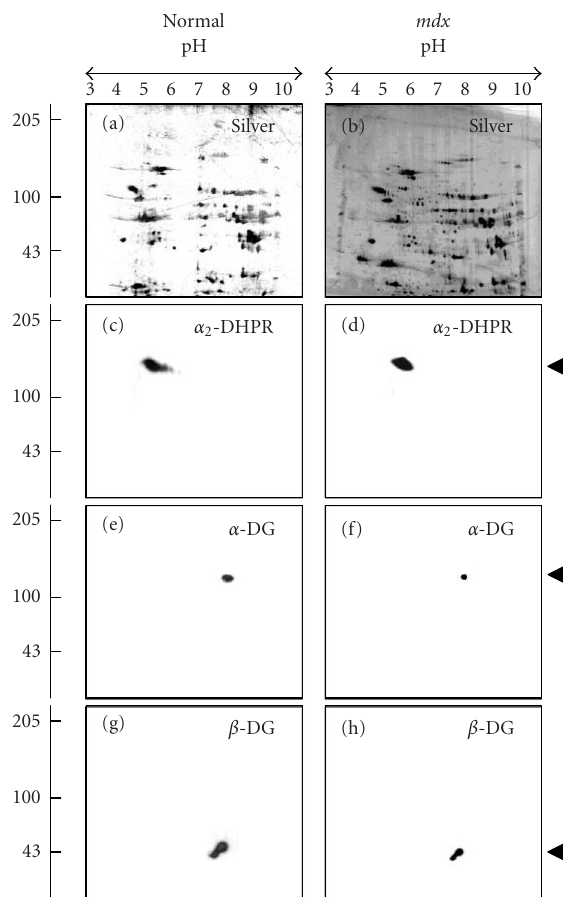
Figure 2. Reduced expression of the dystroglycan complex in dystrophic heart muscle. Shown are silver-stained gels ((a), (b)) and identical immunoblots ((c), (d), (e), (f), (g), and (h)) of 24-week-old normal ((a), (c), (e), (g)) and age-matched mdx ((b), (d), (f), (h)) total heart extracts. Immunoblots were la- belled with antibodies to the α 2 -subunit of the dihydropyridine receptor ( α 2 -DHPR) ((c), (d)), α -dystroglycan ( α -DG) ((e), (f)), and β -dystroglycan ( β -DG) ((g), (h)). The position of immuno- decorated spots is marked by arrow heads. The pH values of the first-dimensional gel system and molecular mass standards (in kd) of the second dimension are indicated on the top and on the left of the panels,